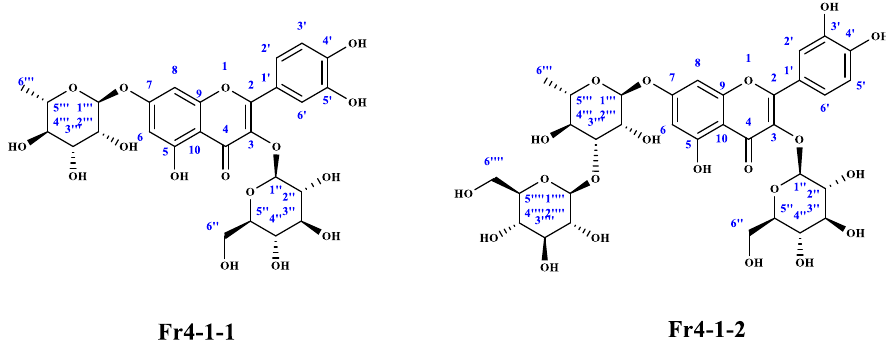
Figure 6. Chemical structures of the isolated compounds.